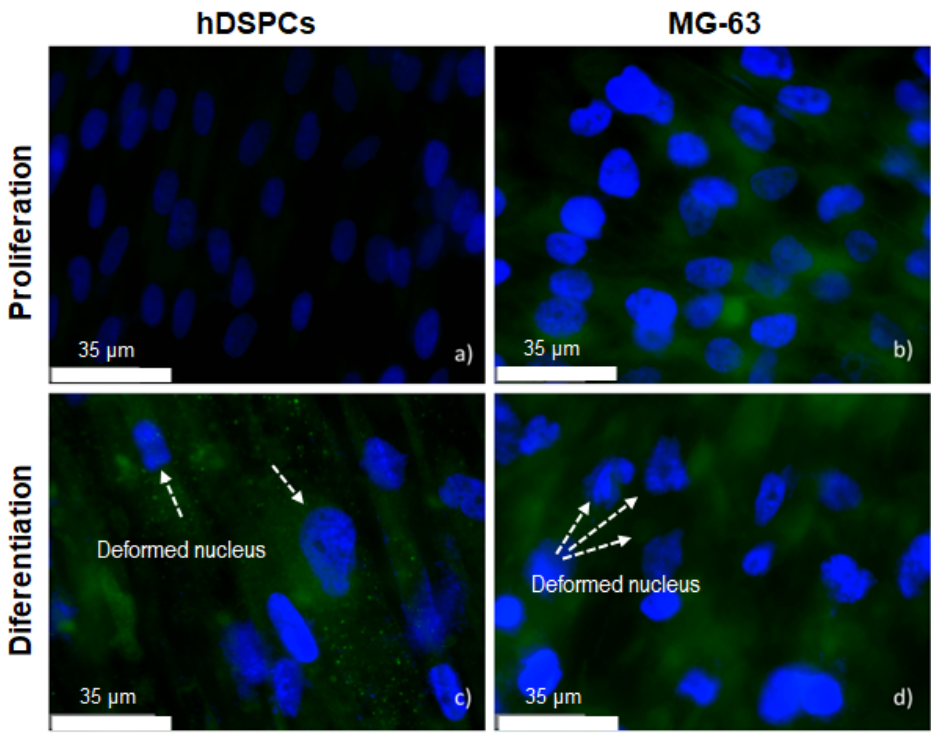
Figure 12. Immunocytochemical staining for osteocalcin counterstained with DAPI in the hDPSCs and MG-63 cells cultured in conventional medium (first line) and differentiation medium (second line). They were all cultivated on as-cast TNZT surfaces (3D). ( a ) Immunocytochemical staining of hDPSCs in contact with the as-cast TNZT surface in conventional culture medium. ( b ) Immunocytochemical staining of MG-63 in contact with the as-cast TNZT surface in conventional culture medium. ( c ) Immunocytochemical staining of hDPSCs in contact with the as-cast TNZT surface in differentiation culture medium. ( d ) Immunocytochemical staining of MG-63 in contact with the as-cast TNZT surface in differentiation culture medium.